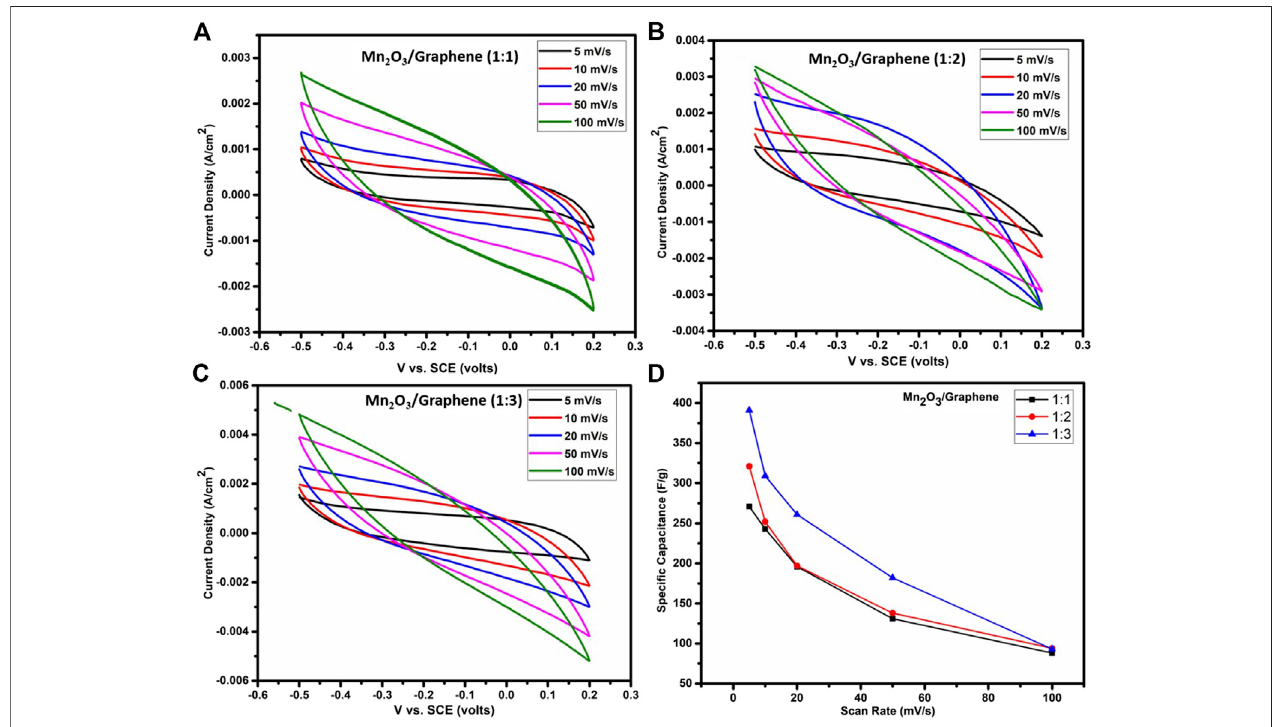
FIGURE 3 | The CV ’ s recorded at a scan rate of 5 mV/s to 100 mV/s of Mn 2 O 3 /graphene composite for (A) (1:1), (B) 1:2, (C) 1:3, and (D) comparison of speci fi c capacitance of all three nanocomposites.